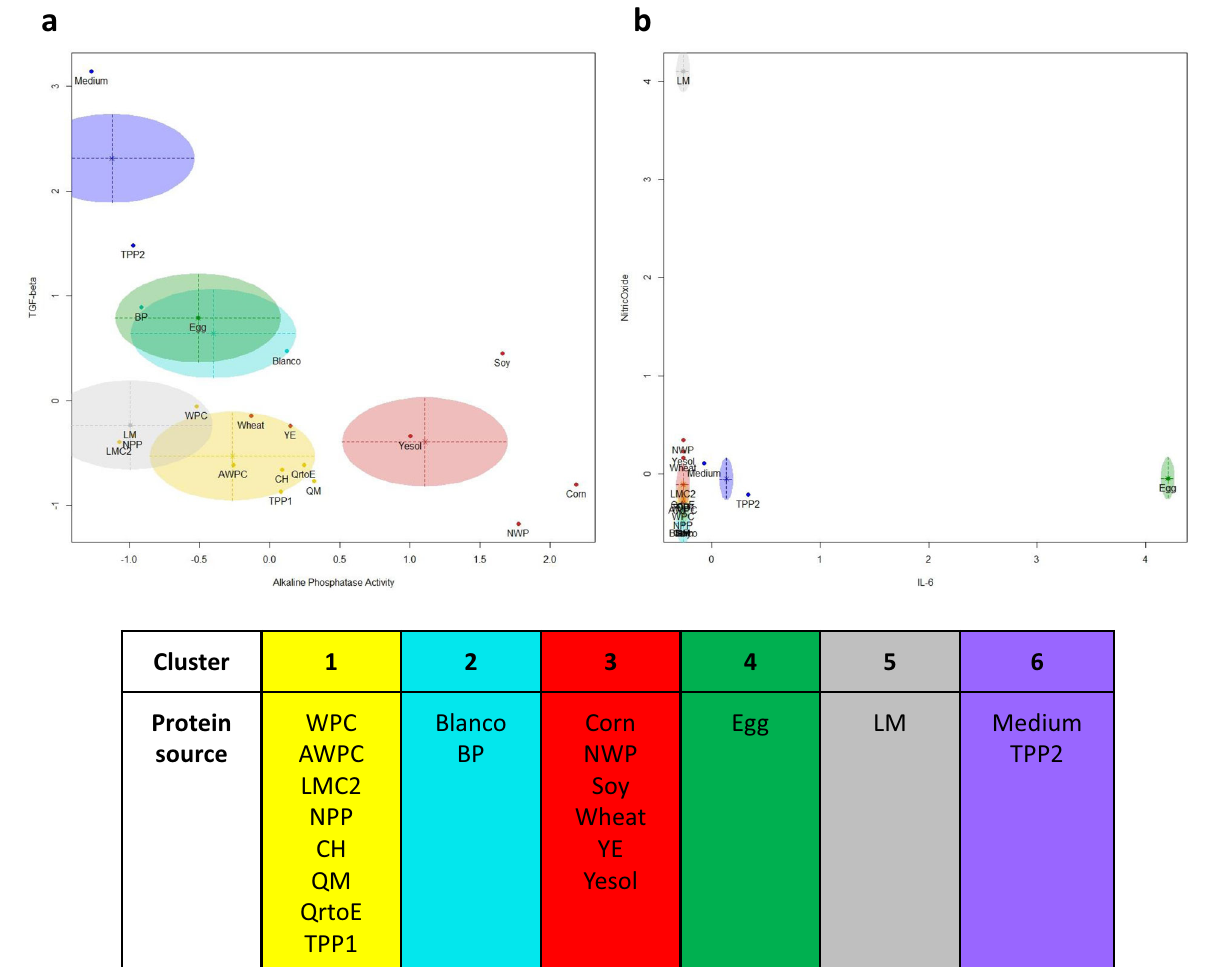
Fig. 2 Holistic clustering of potential dietary protein based on intestinal biological ef fi cacy data. The optimal cluster method ellipsoidal, equal volume, shape and orientation (EEE) and number of clusters (6) were determined using the Bayesian Information Criterion. a Two- component plot showing TGF β secretion (vertical axis) and alkaline phosphatase activity (horizontal axis). b two-component plot showing nitric oxide (vertical axis) and IL-6 (horizontal axis). Supplementary Fig. 9 shows all combinations of two-component plots. Analysis was done based on inulin-FITC leakage, zonula occludens-1 (ZO-1) expression quanti fi cation, tissue viability, alkaline phosphatase activity, IL-6 secretion, TGF- β secretion, and NO